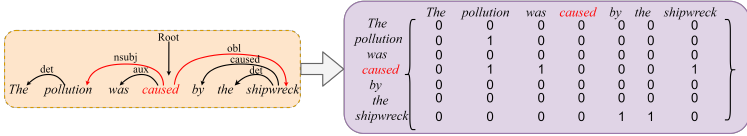
Figure 7. Dependency tree example of causal relational sentence